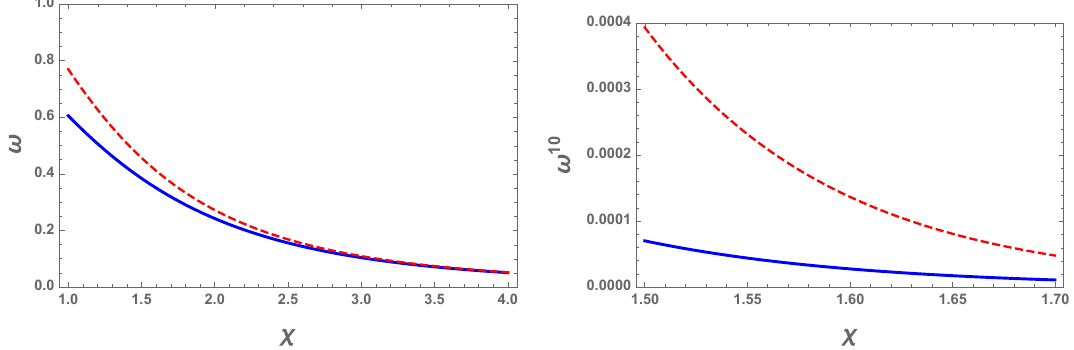
p 2 . (1+ (cid:31) 2 = 2) 3 = 2